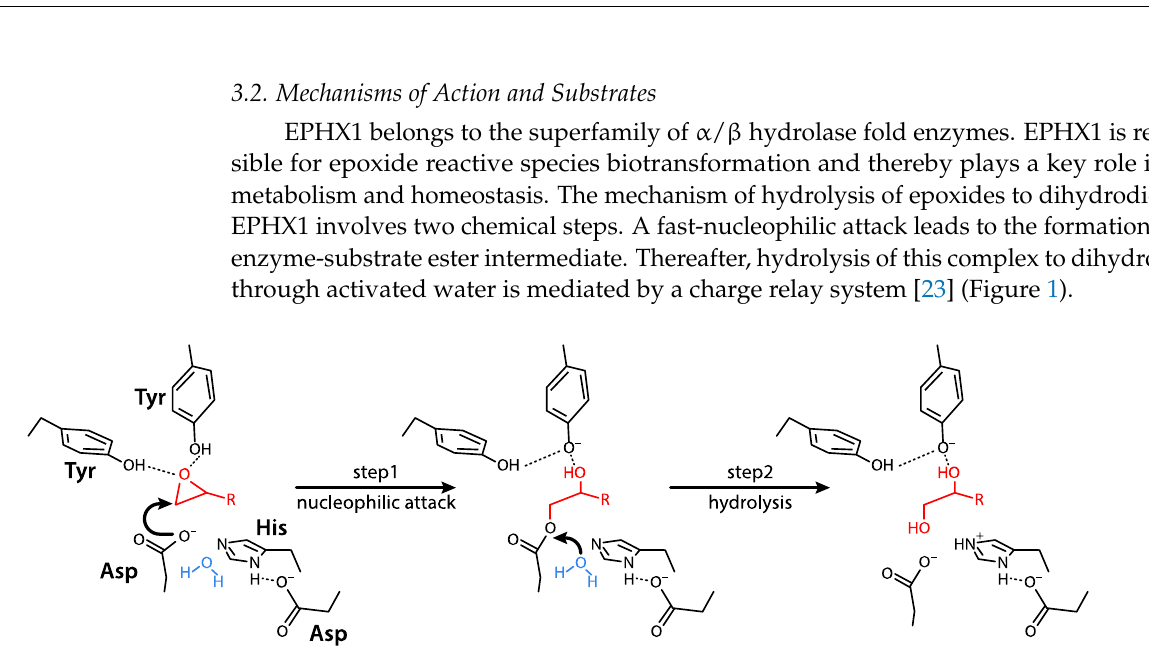
Figure 1. Two-step enzymatic mechanism of α / β hydrolase fold EHs. In the first step, EH forms a covalent bond with its substrate. In the second step, the resulting ester is hydrolyzed. The epoxide core of the substrate is depicted in red, water (H 2 O) in blue, and the different parts of the EH enzyme in black, with the catalytic site residues appearing in bold characters. This figure is adapted from Decker et al. [10].